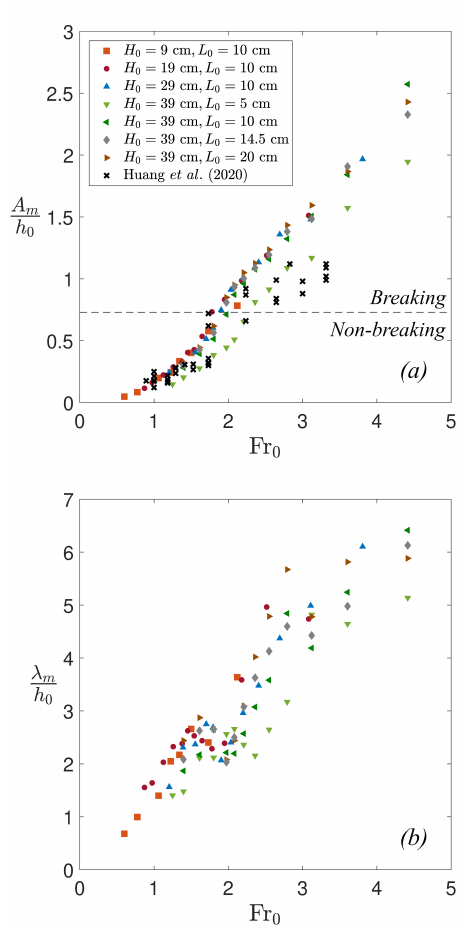
Figure 2. Pictures of the three typical wave shapes observed for di ff erent initial conditions : (a) nonlinear transition wave ( H 0 = 39 cm, L 0 = 5 cm, h 0 = 25 cm), (b) solitary wave ( H 0 = 29 cm, L 0 = 10 cm, h 0 = 9 cm), and (c) hydraulic jump ( H 0 = 39 cm, L 0 = 14.5 cm, h = 3 cm). 0